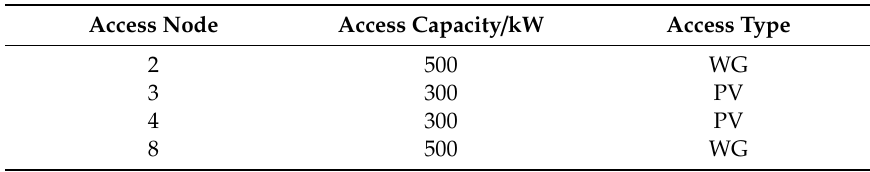
Table 3. Connections of the “Units” of ADS.